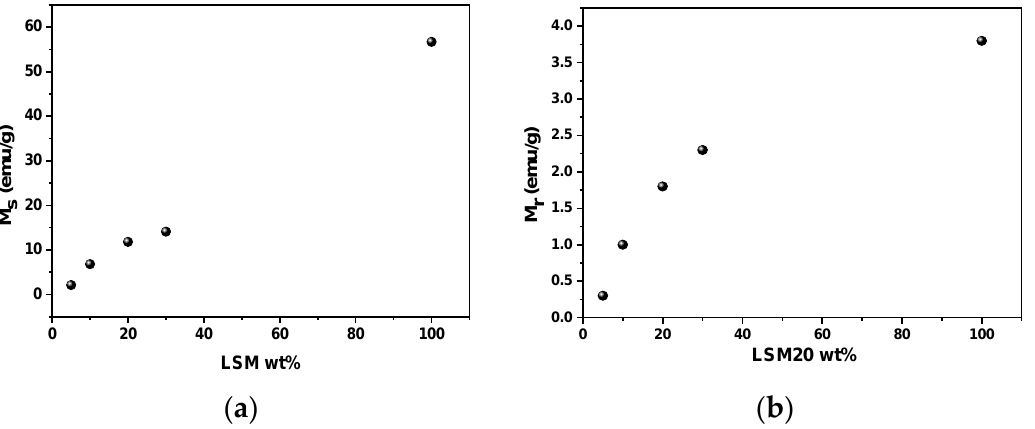
Figure 11. Saturation magnetization–M s ( a ) and Remanence–M r ( b ) as a function of the LSM amount in the composites, evaluated from M-H loop at 300 K-accuracy 10 −8 emu. The value of 100% corresponds to the pure La 0.8 Sr 0.2 MnO 3 .